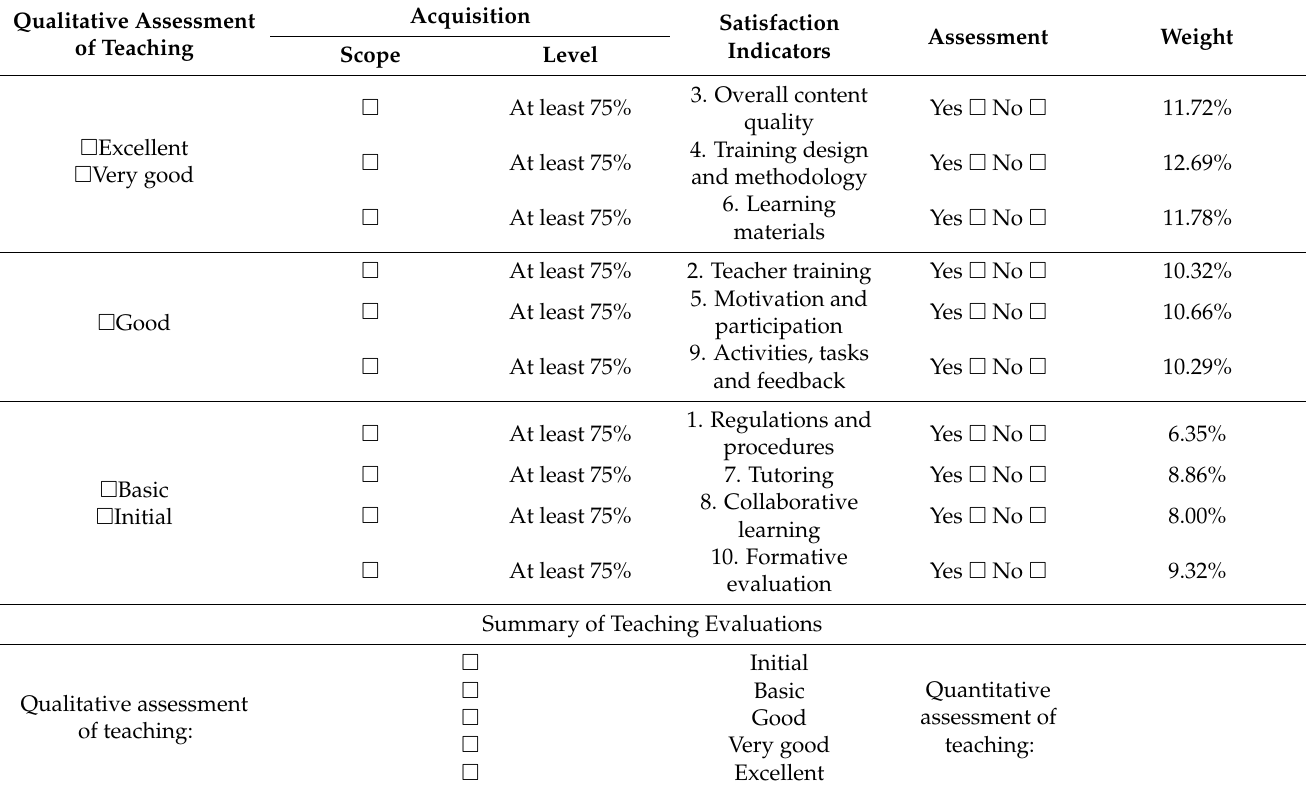
Table 7. SULODITOOL ® instrument adapted to scenario 6 of non-face-to-face post-compulsory education with synchronous modality.